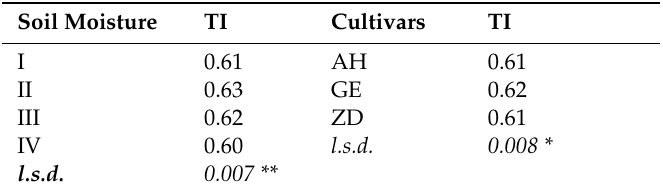
Table 2. Mean topological index (TI) under various soil moisture (See Table 1 for soil moisture abbreviations) and cultivar (AH, GE and ZD) treatments. * p < 0.05; ** p < 0.01.